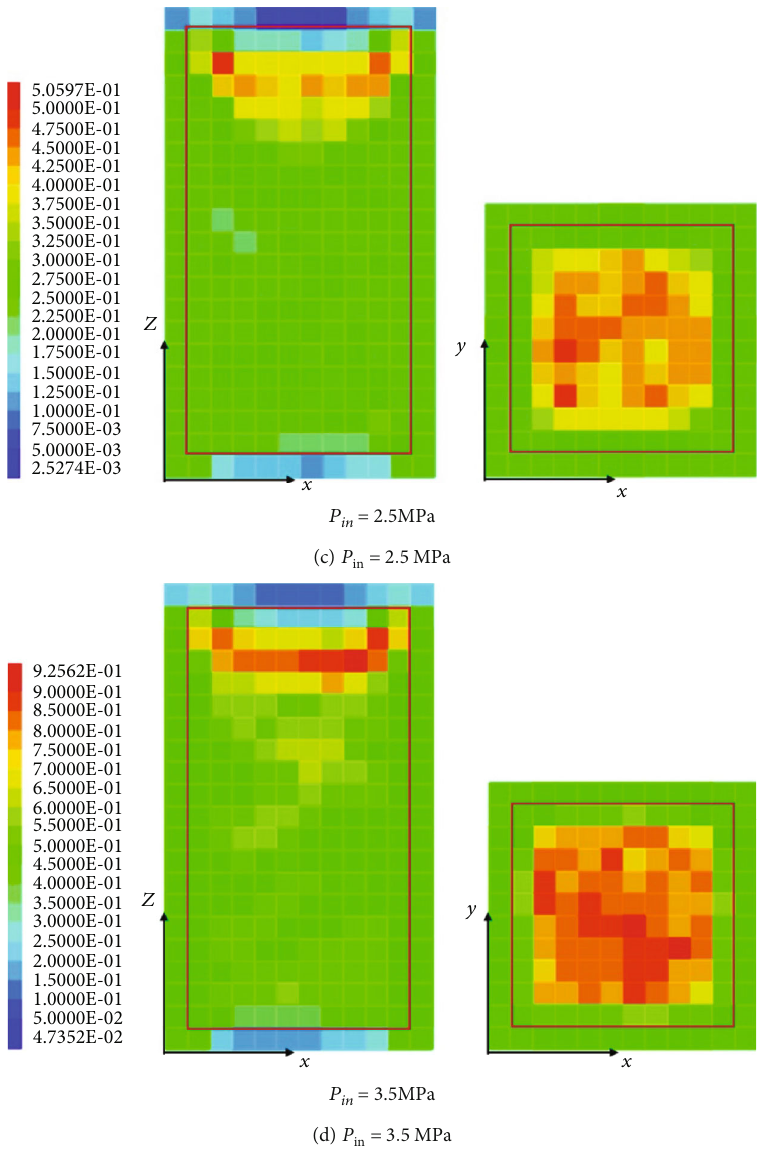
Figure 7: Distribution diagram of pressure gradient of seepage